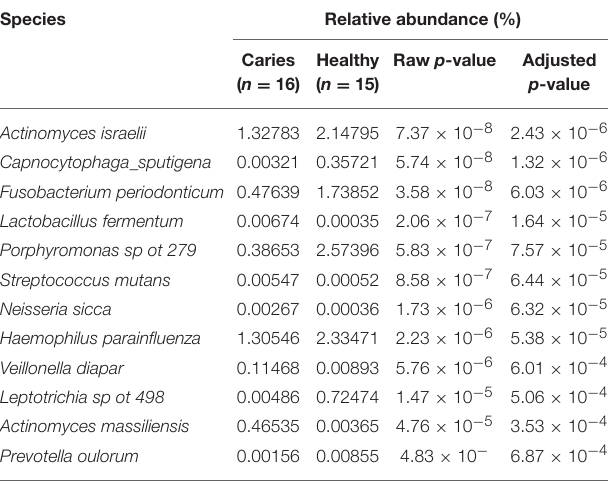
TABLE 2 | The species identified with significantly different relative abundance in samples from individuals with caries and caries-free groups. Species Relative abundance (%) Caries Healthy Raw p ( n = 16) ( n = 15)